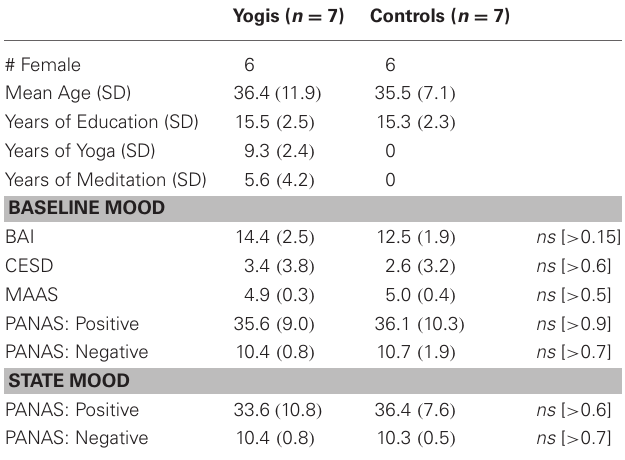
Table 1 | Subject demographics and self report.